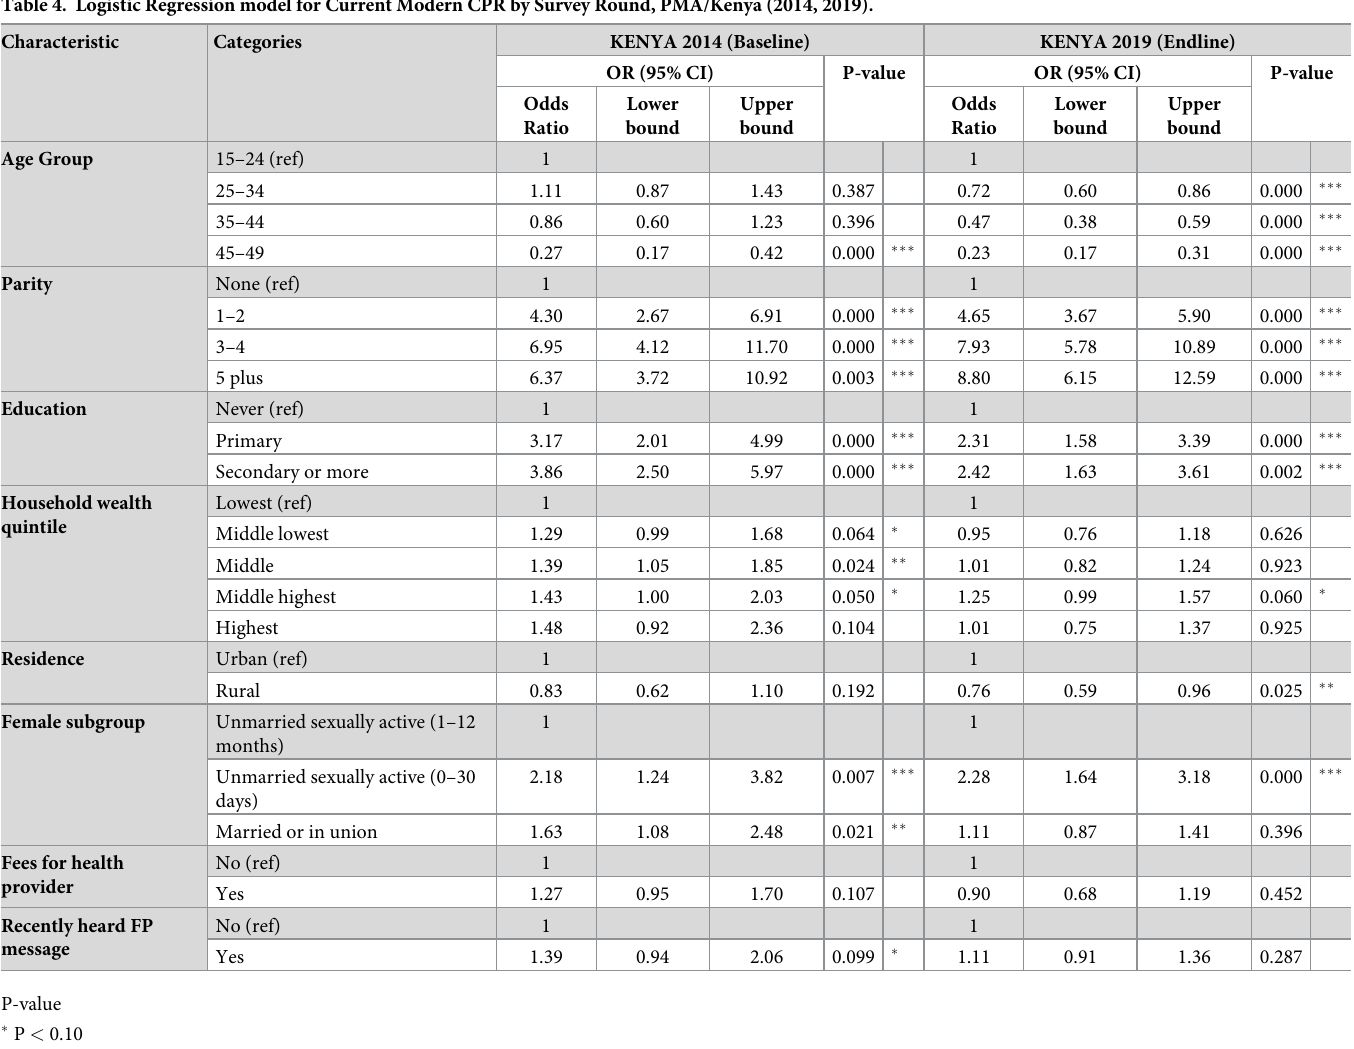
Table 4. Logistic Regression model for Current Modern CPR by Survey Round, PMA/Kenya (2014, 2019). Characteristic